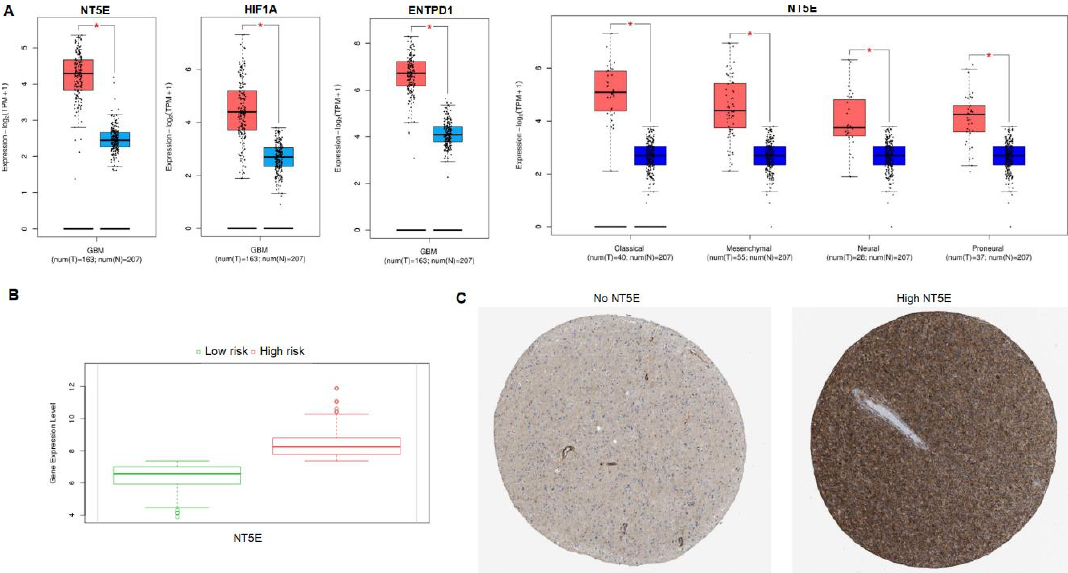
Figure 1. Expression of NT5E in glioblastoma (GBM). ( A ) Expression of NT5E , HIF1A , and ENTPD1 in GBM (red) and normal brain (blue) based on TCGA data analyzed by GEPIA2 ( n = 163). NT5E expression was also analyzed with TCGA data stratified into GBM subtypes: Classical, mesenchymal, neural, and proneural. All samples showed higher target gene expression in GBM compared to normal tissue (* p < 0.01). ( B ) Expression of NT5E in GBM based on risk group. High risk patients showed higher expression of NT5E compared to low risk patients. Risk group analysis was done in SurvExpress ( p = 4.91 × 10 −6 ; n = 538). ( C ) Immunohistochemical staining of glioma tissue obtained from the Human Protein Atlas showing NT5E -negative tissue (female, age 36; left ) and high NT5E -expressing glioma tissue (male, age 71; right ).